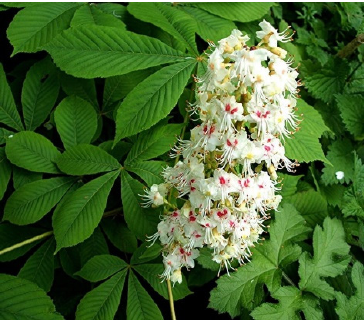
Figure 4. Flowers of Aesculus hippocastanum (horse chestnut flowers).